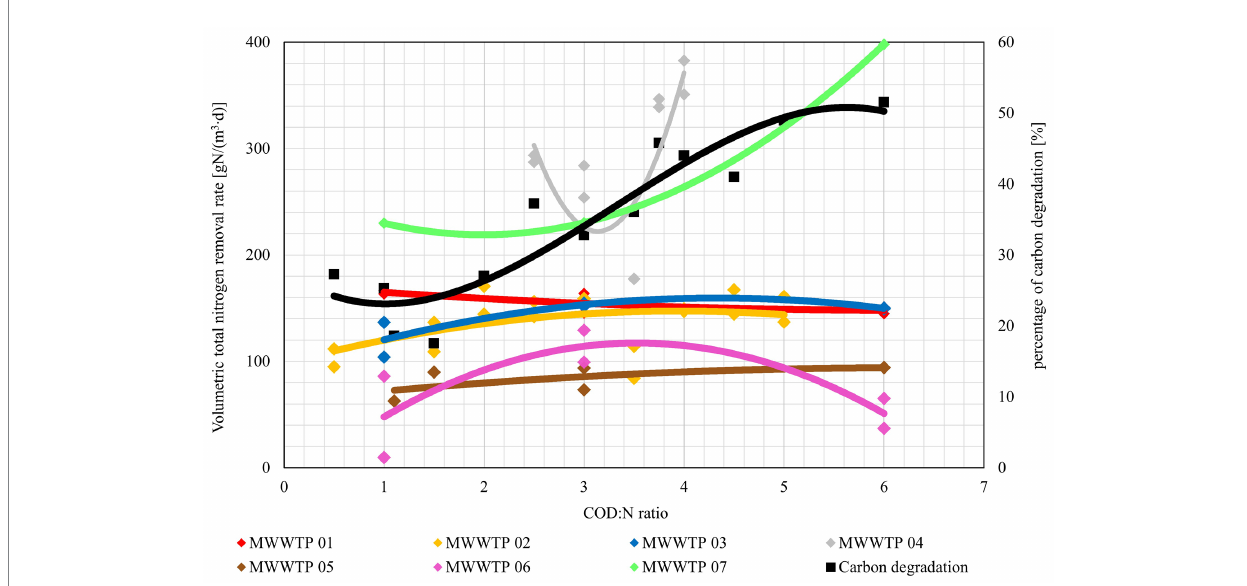
FIGURE 4 The volumetric nitrogen removal rate of the deammonification process for various deammonifying sludges as a function of COD:N